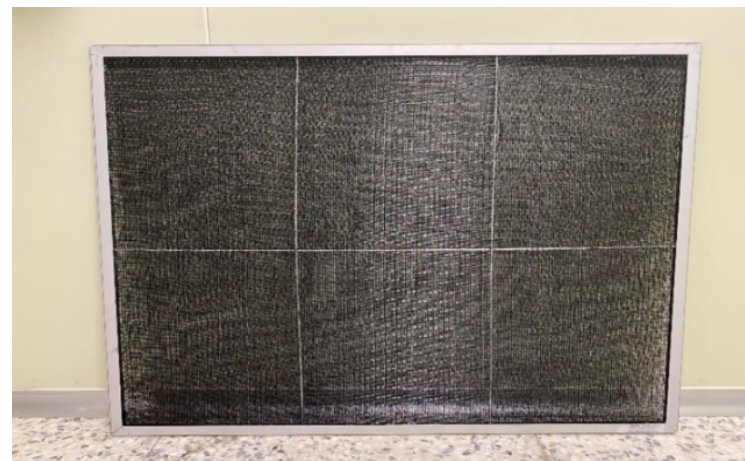
Figure 15. Primary filter screen. Table 2. Air purifier filter screen pressure and air volume.